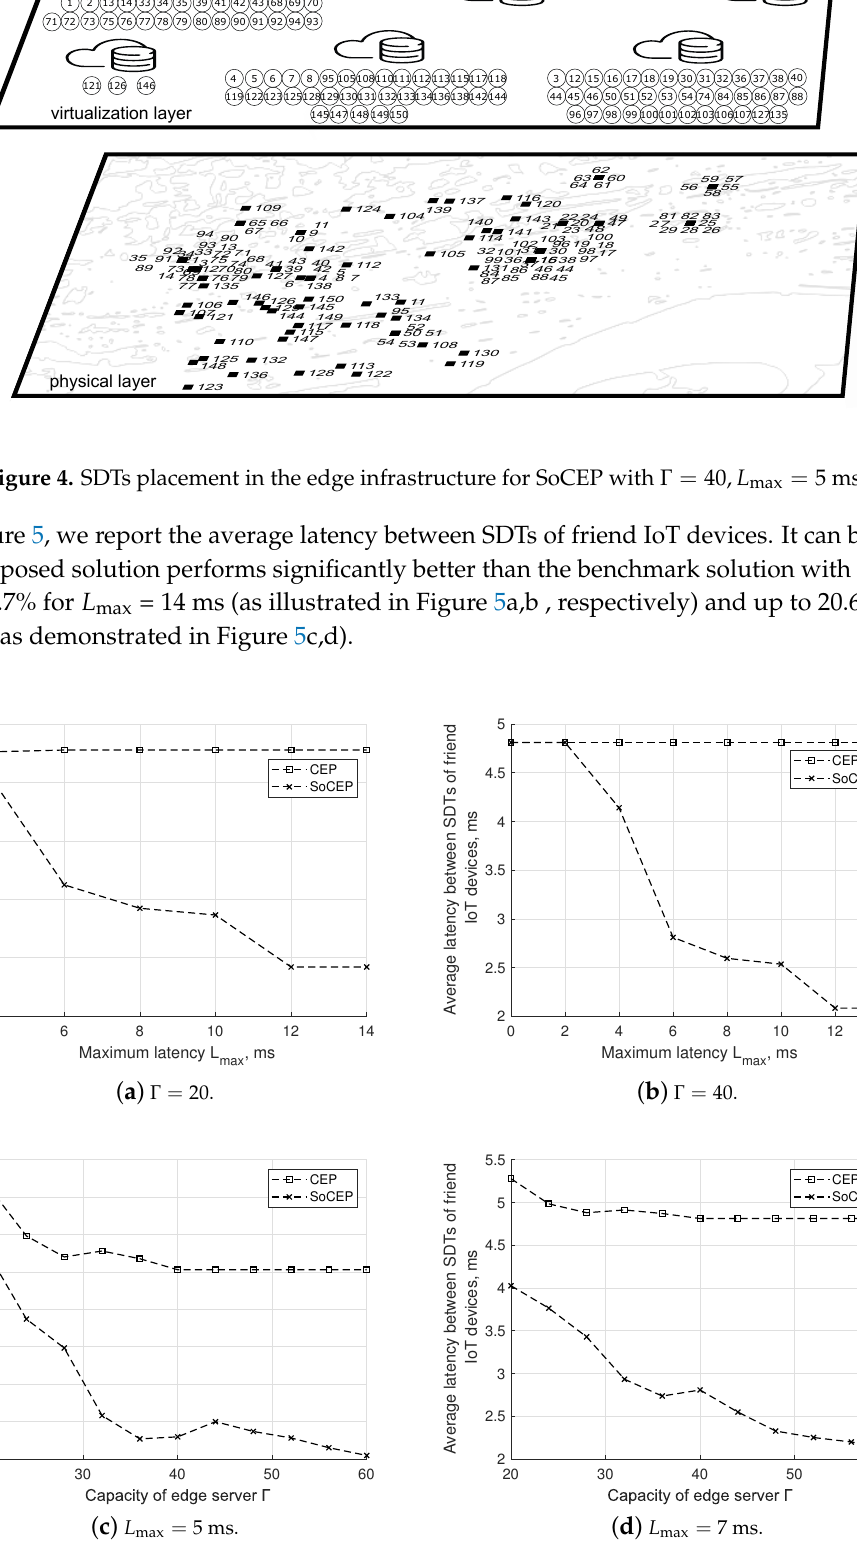
Figure 5. SoCEP vs. CEP: average latency between SDTs of friend IoT